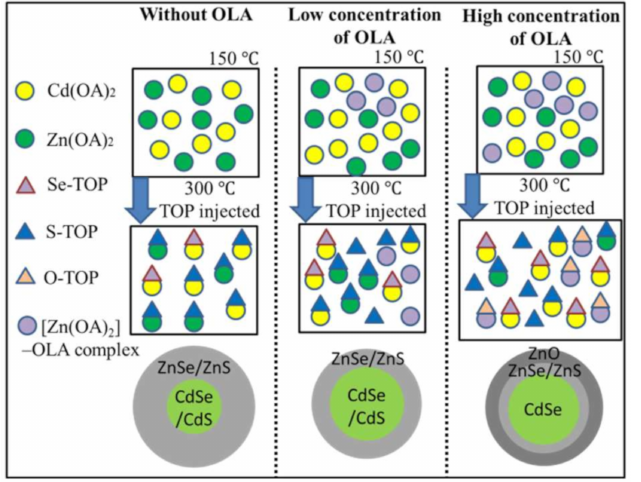
Figure 9. The illustration of the chemical reaction mechanisms by one-pot chemical synthesis of CdSe/CdS/ZnS QDs with different concentration of